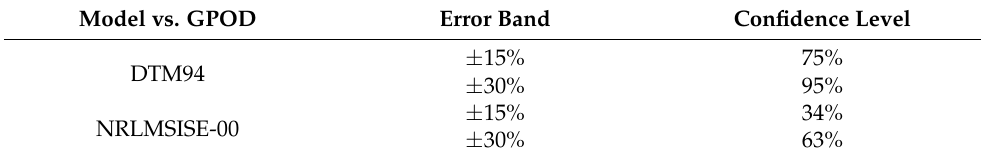
Table 2. The error distributions of the two models relative to GPOD. Model vs.